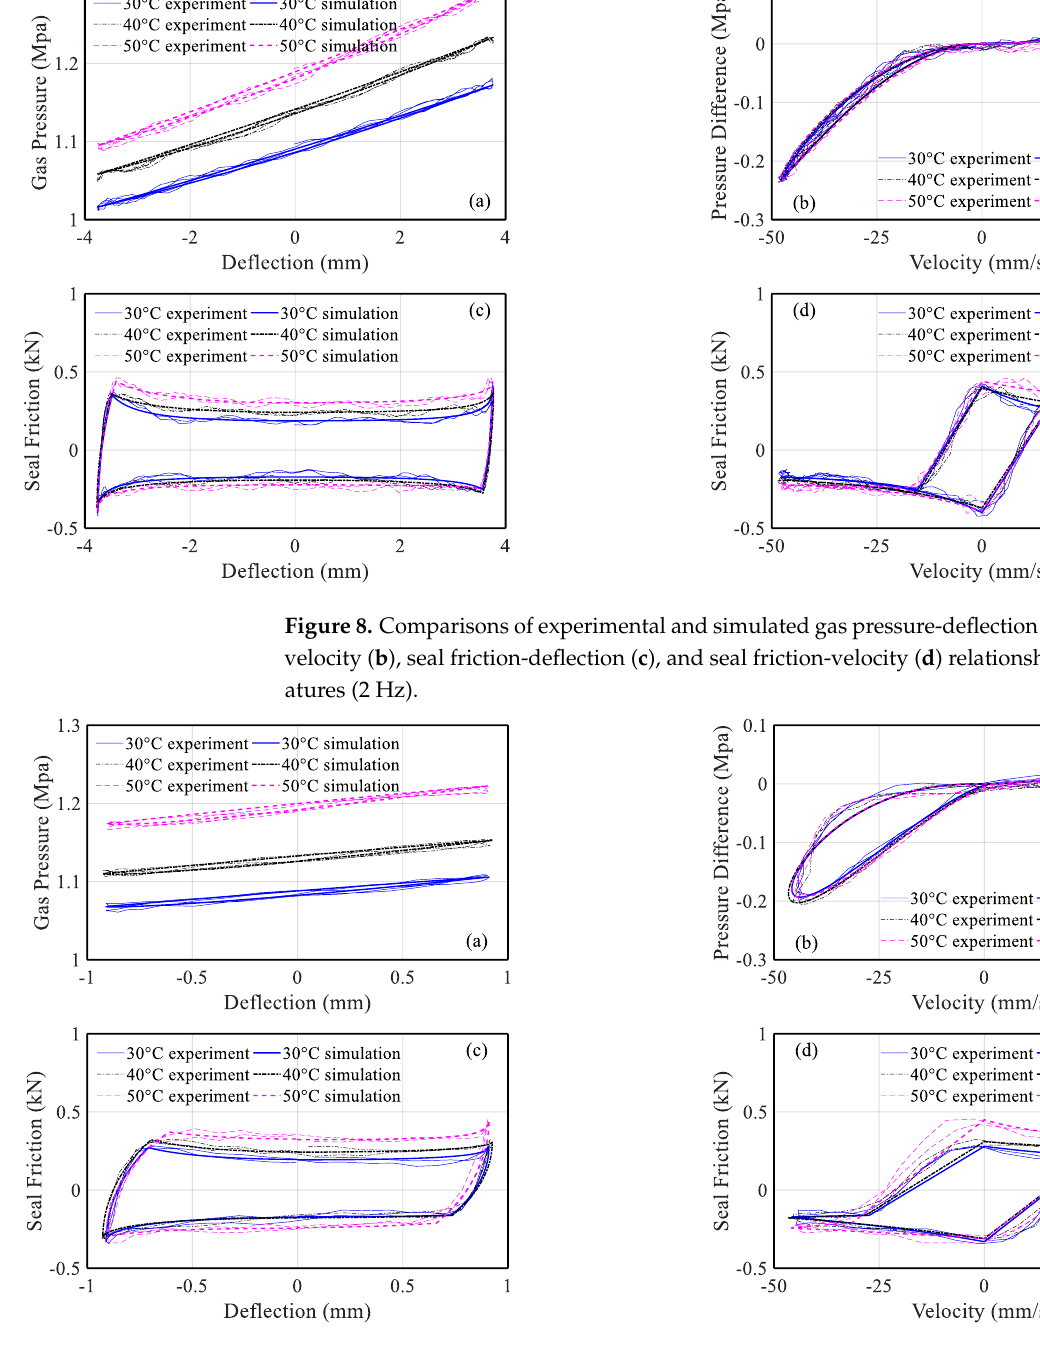
Figure 9. Comparisons of experimental and simulated gas pressure-deflection ( a ), pressure difference-velocity ( b ), seal friction-deflection ( c ), and seal friction-velocity ( d ) relationships at different temperatures (8 Hz).